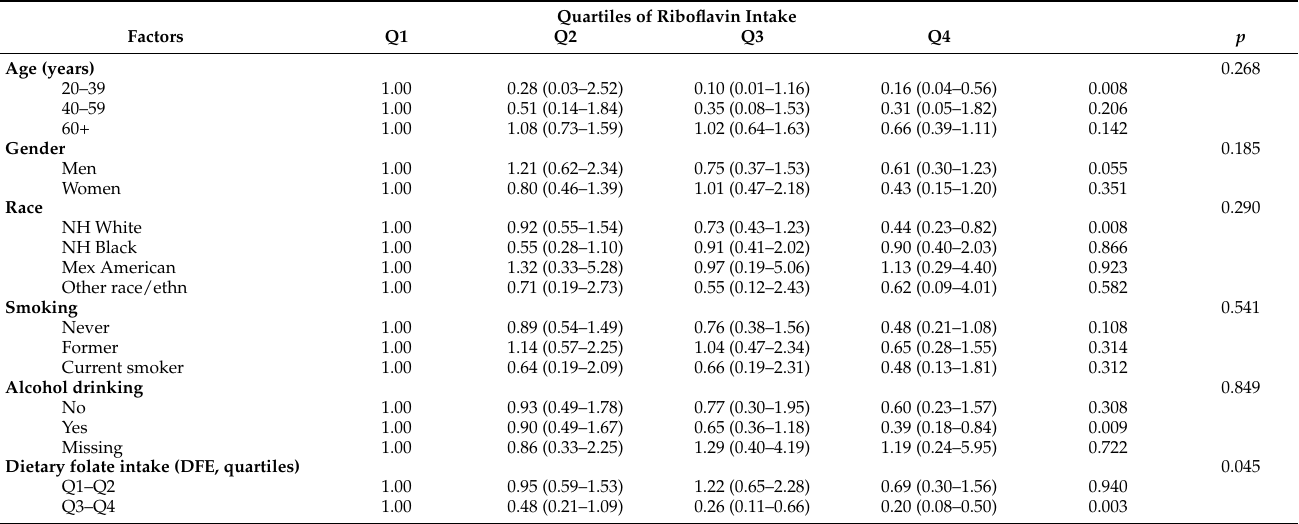
Table 3. Subgroup analyses of the association between quartiles of riboflavin intake and CVD mortality. Quartiles of Riboflavin Intake Factors Q1 Q2 Q3 Q4